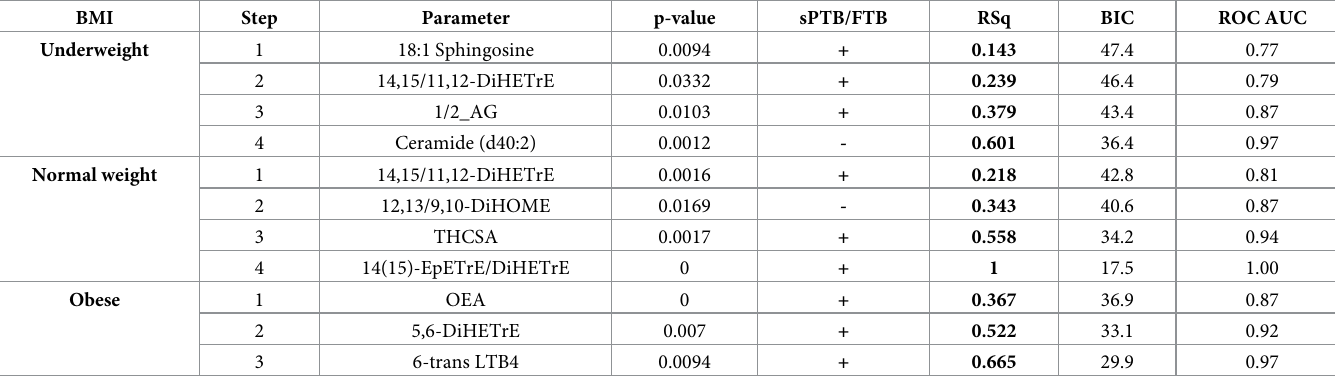
Table 1. Prediction of preterm delivery using serum lipid mediators.